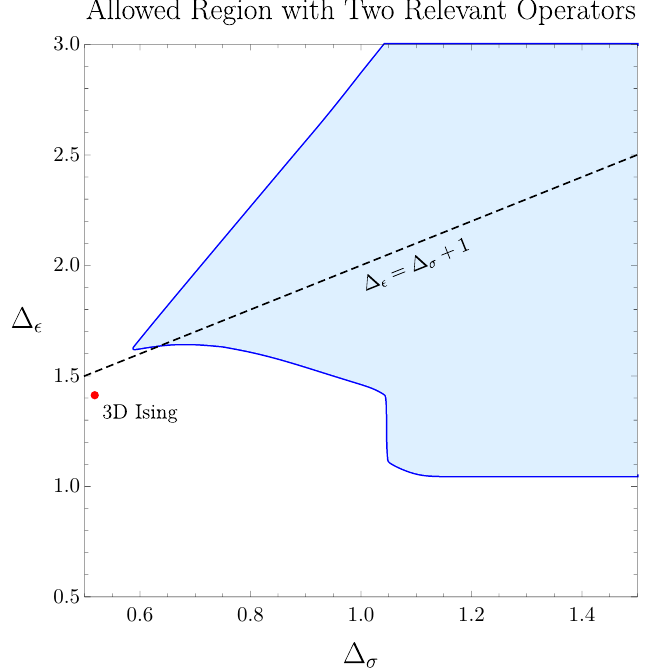
Figure 1 . A plot of the allowed region of 3D CFTs with a Z 2 symmetry. Here we assume two relevant operators, (cid:27) and (cid:15) , taken to be odd and even under the Z 2 symmetry, respectively. This plot assumes the permutation symmetry (cid:21) (cid:27)(cid:15)(cid:27) = (cid:21) (cid:27)(cid:27)(cid:15) . The Z 2 symmetry may be either an internal symmetry or a parity symmetry. The shaded area is not excluded. In this plot we use (cid:3) = 25. In the above equations, O + runs over Z -even operators of even spin and O (cid:0) runs over 2 Z -odd operators of any non-negative integer 2